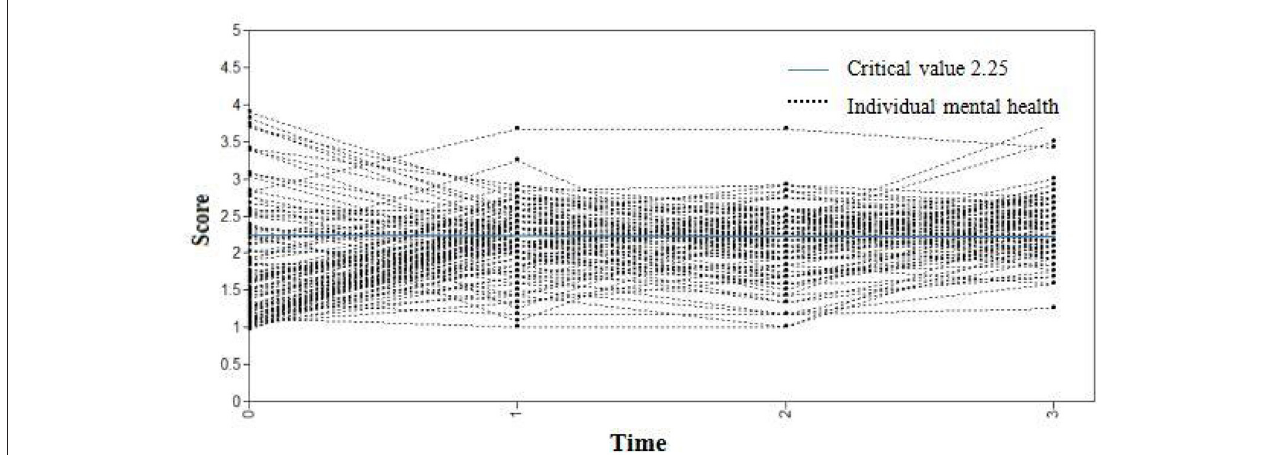
FIGURE 4 | The changing trajectory of mental health level of medical staff after adjustment.